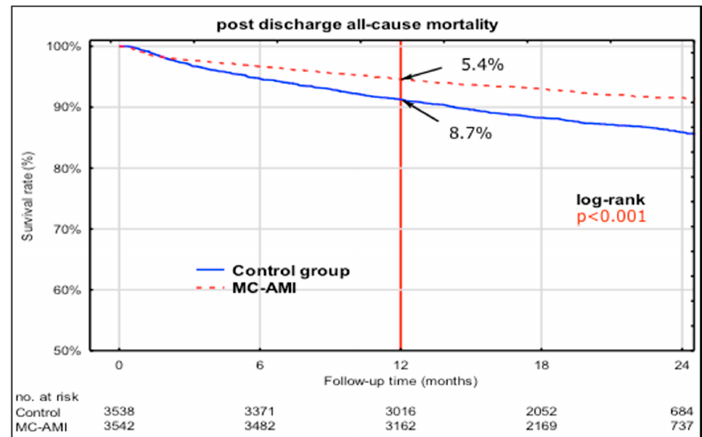
Figure 2. Kaplan–Meier curves showing freedom from all cause mortality—propensity score matching—12-month follow up analysis for the entire study group (7102 subjects). Follow-up extended to 24 months showing persistent e ff ect after the program had been completed. MC-AMI: managed care after acute myocardial